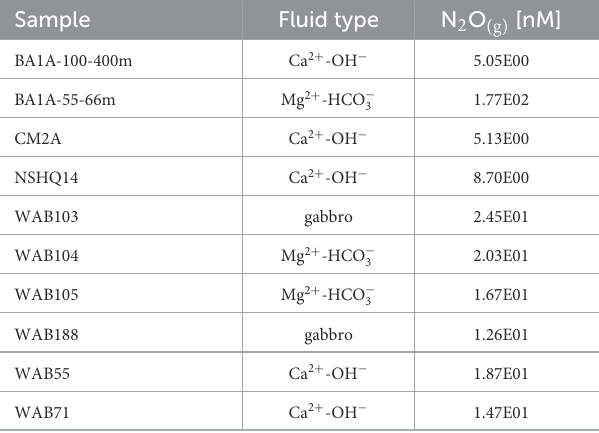
TABLE 5 Concentrations of dissolved N 2 O measured in gases collected from the 2018 fluids via the bubble strip method.